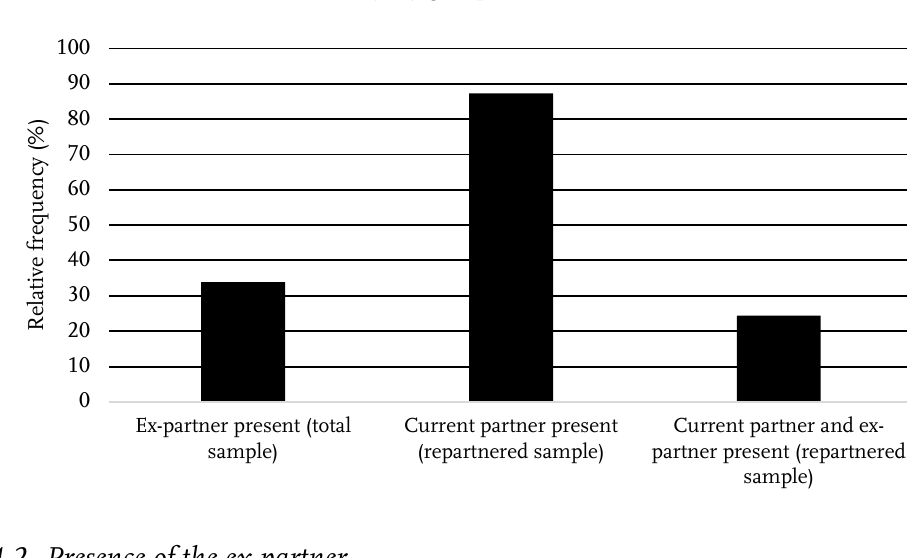
Figure 1 : Relative frequencies of ex-partner’s, current partner’s, and their joint presence at the child’s last birthday, by